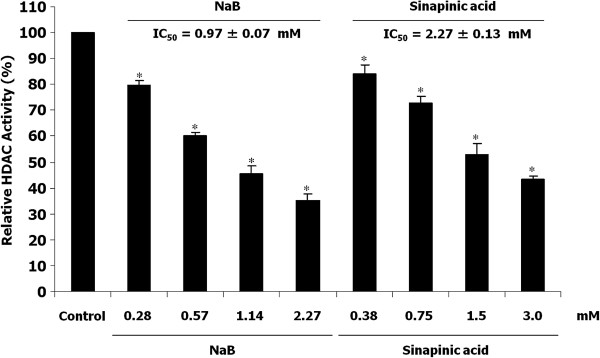
In vitro HDAC inhibitory activity of sinapinic acid. Results were expressed as relative HDAC activity with respect to the vehicle control (DMSO). Sodium butyrate (NaB) at indicated concentrations was studied comparatively. Each value represents the mean ± SD of three experiments, performed in duplicate. Asterisks (*) denote significant differences vs control (p < 0.05). Half maximal inhibitory concentration (IC50) values represent concentrations of the indicated compounds that inhibit 50% of HDAC activity in vitro.